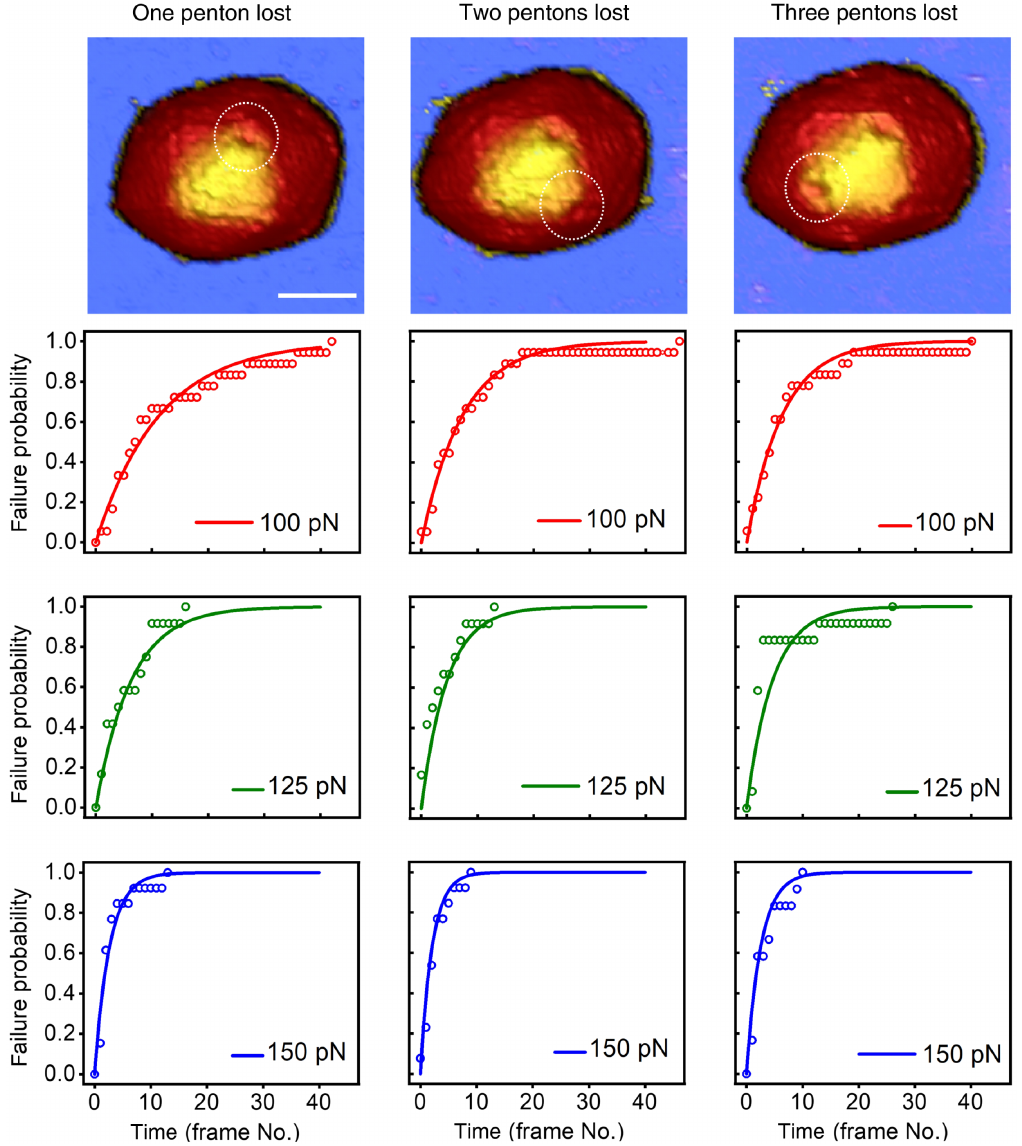
FIG. 3. Penton release distribution under Markov process model. Top: AFM images taken after the first, second, and third penton- escape events (in the left panel, the scale bar corresponds to 44 nm). White circles mark the penton vacancies. Bottom: cumulative probability of penton failure P i ð n Þ for successive penton escapes when the capsid is exposed to strokes of forces of 100 pN, 125 pN, and 150 pN (right panel). Dots represent the experimental data, and dashed lines represent the model results [Eq.